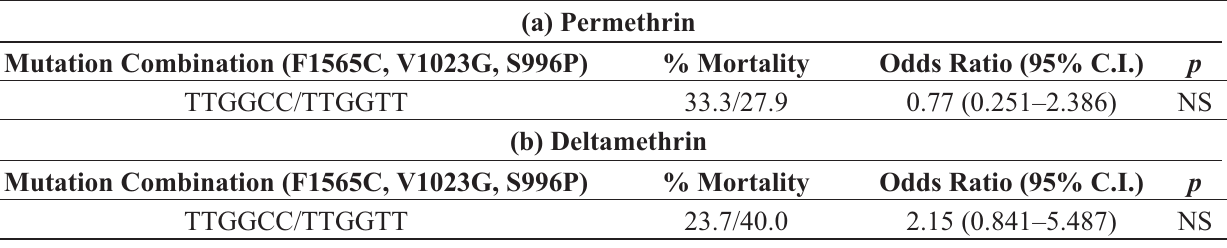
Table 11. Chance of Aedes aegypti being resistant to a pyrethroid insecticide (( a ). permethrin Type I and ( b ) deltamethrin Type II) if multiple Vssc mutations are present (data from Yogyakarta Site 6, Site 8 and w MelYog